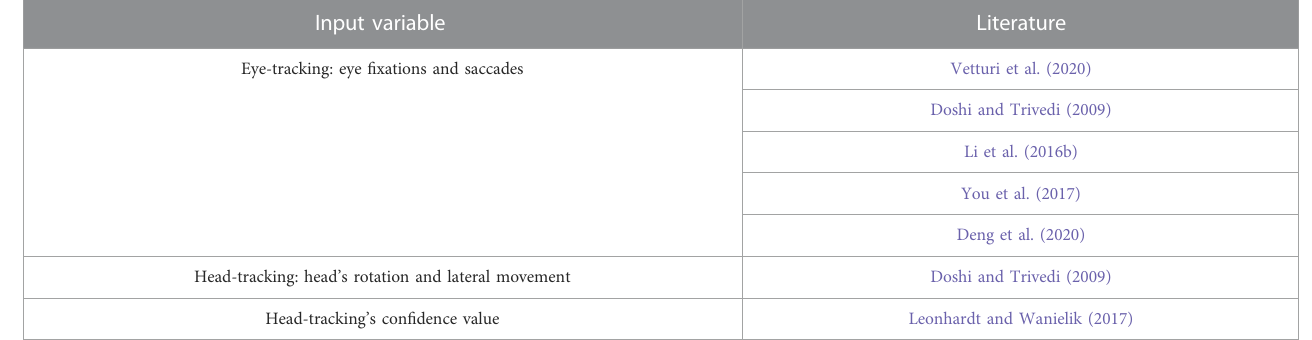
TABLE 2 Summary of eye- and head-tracking